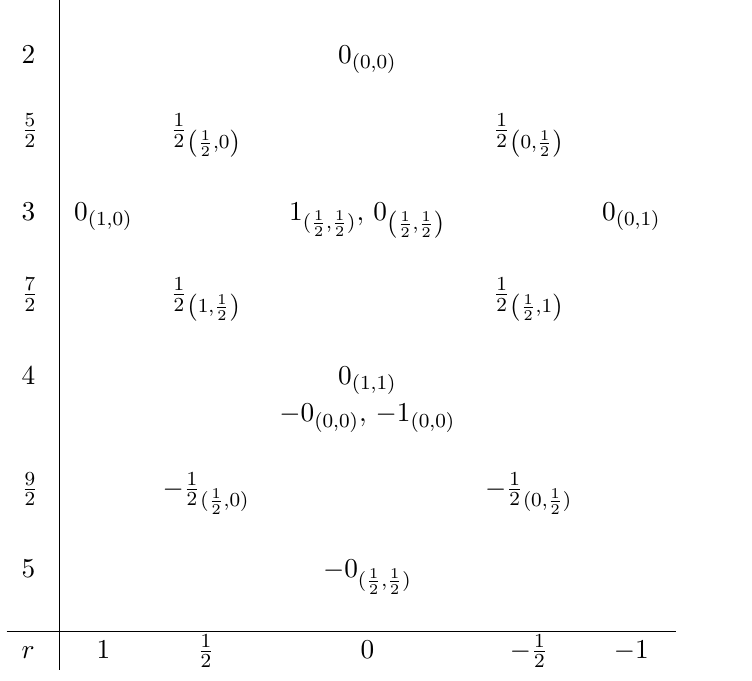
Table 2 . The quantum numbers for the states in the ^ C